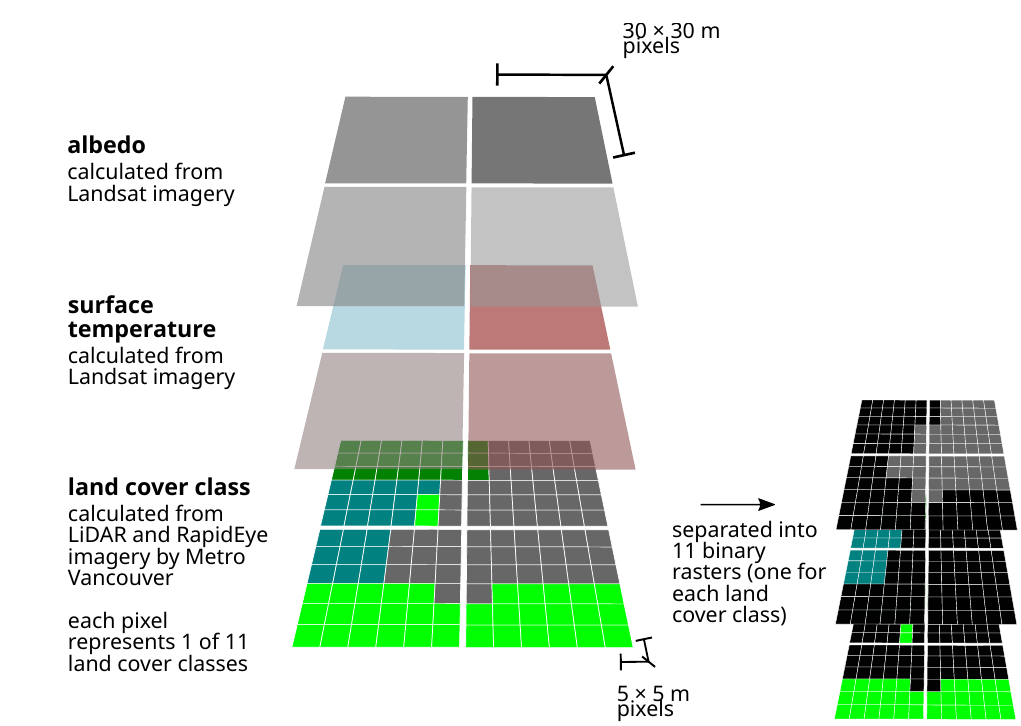
Figure 2. Diagram showing the three layers of data and spatial resolution of each. Albedo and surface temperature were derived from Landsat data and had pixel dimensions of 30 × 30 m. The land cover classes were taken from Metro Vancouver, and were ultimately derived from LiDAR data and RapidEye multispectral satellite imagery. Each land cover class pixel was 5 × 5 m. Thus, 36 land cover class pixels are together associated with a single surface temperature pixel. The land cover class raster was separated into 11 binary rasters for analysis (only 3 shown here for